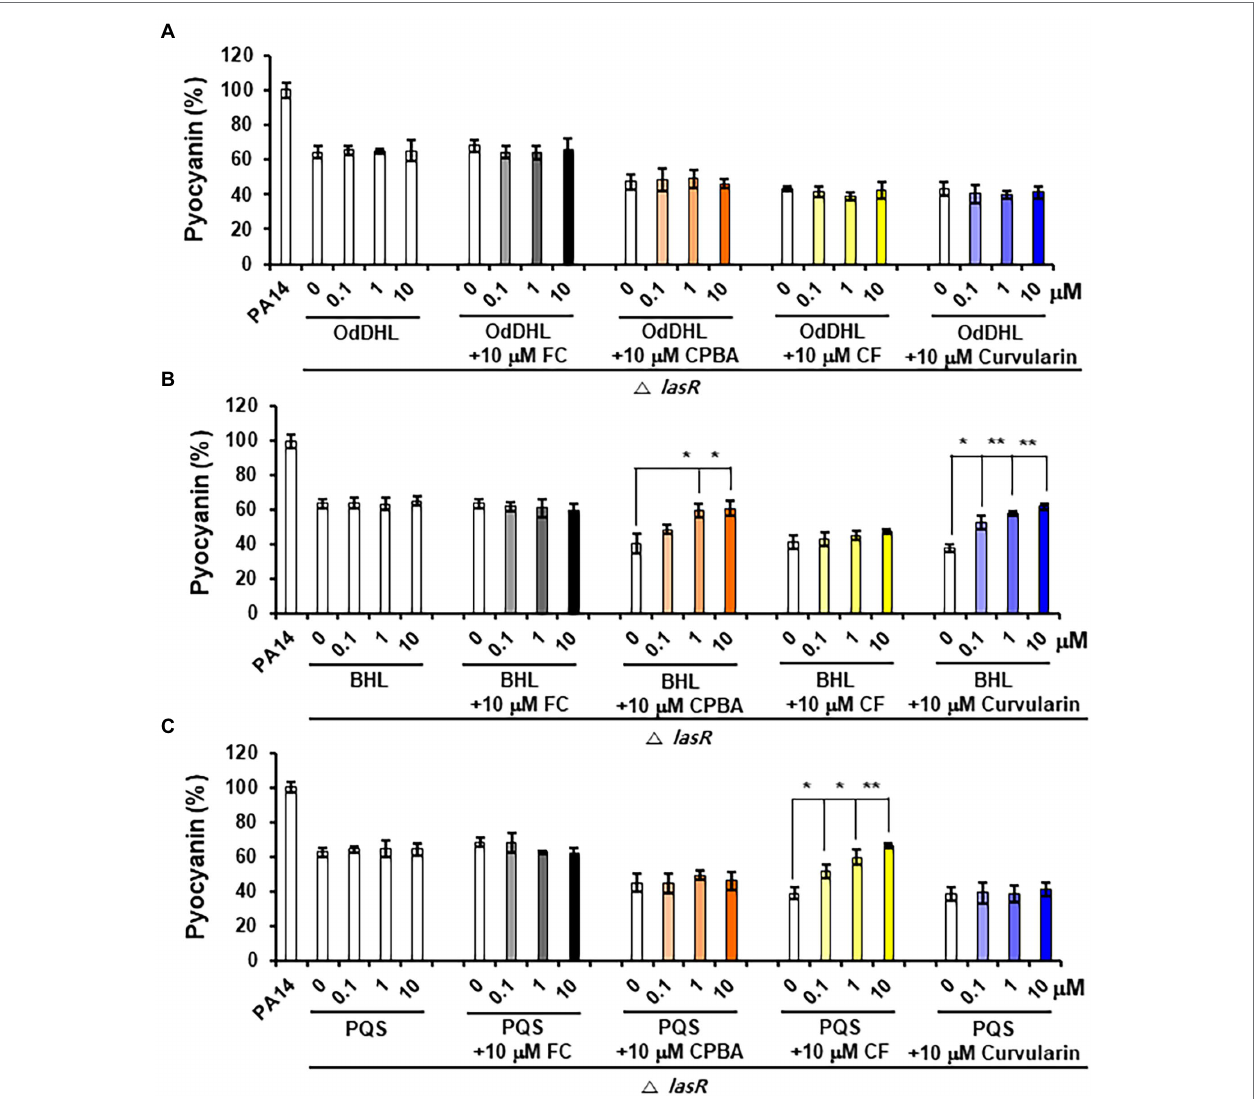
FIGURE 6 | Effects of exogenous QS ligands on curvularin-mediated inhibition of pyocyanin production in the Δ lasR mutant. Pyocyanin production in the Δ rhlR mutant cultured with curvularin (10 μ M) in the presence or absence of different concentrations of OdDHL (A) , BHL (B) , or PQS (C) for 18 h. FC, CPBA, and clofoctol (CF) are known antagonists of LasR, RhlR, and PqsR, respectively. The data are representative of three independent experiments performed in triplicate and expressed as the mean ± SD values in each bar. * p < 0.01 and ** p < 0.001 versus DMSO